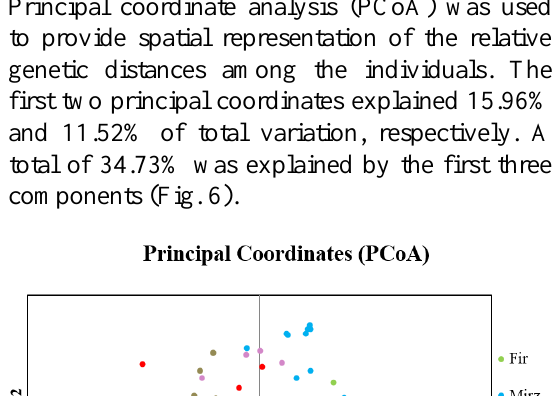
Table 5. Analysis of molecular variance (AMOVA) for L. undulata by ISSR. Source of variation df Sum of squares MS Variance components % Variation Among Pops 4 262.720 65.680 2.900 27% Within Pops 95 728.850 7.672 7.672 73% Total 99 991.570 10.573 100% *Based on the Mantel test, the correlation between genetic and geographical distances was weak (r= 0.148, P <0.01) (Supplement 3).